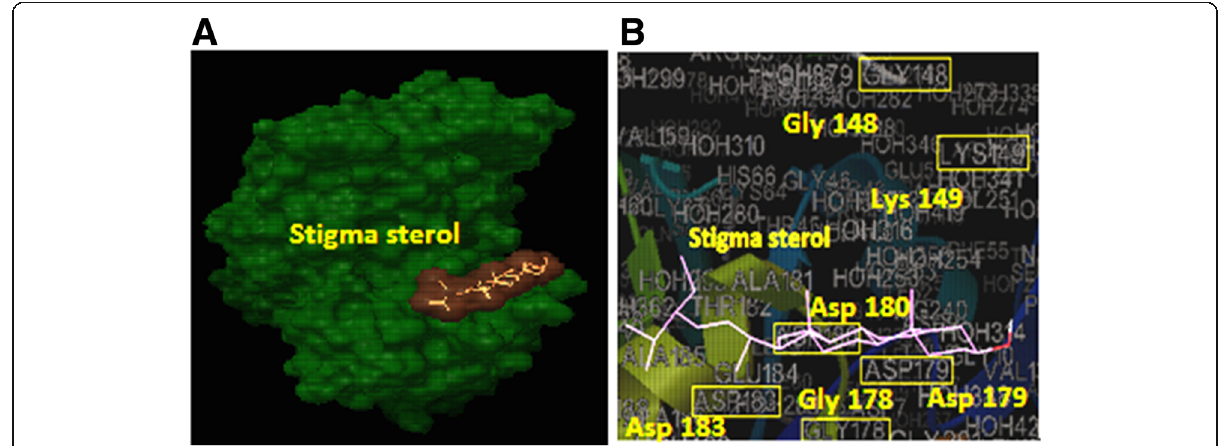
Fig. 8 a , b Docking pose of model TPP with phytochemical